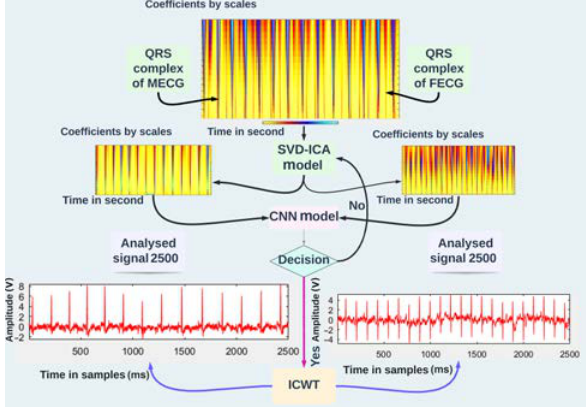
Fig. 9 FECGr and MECGr signals.